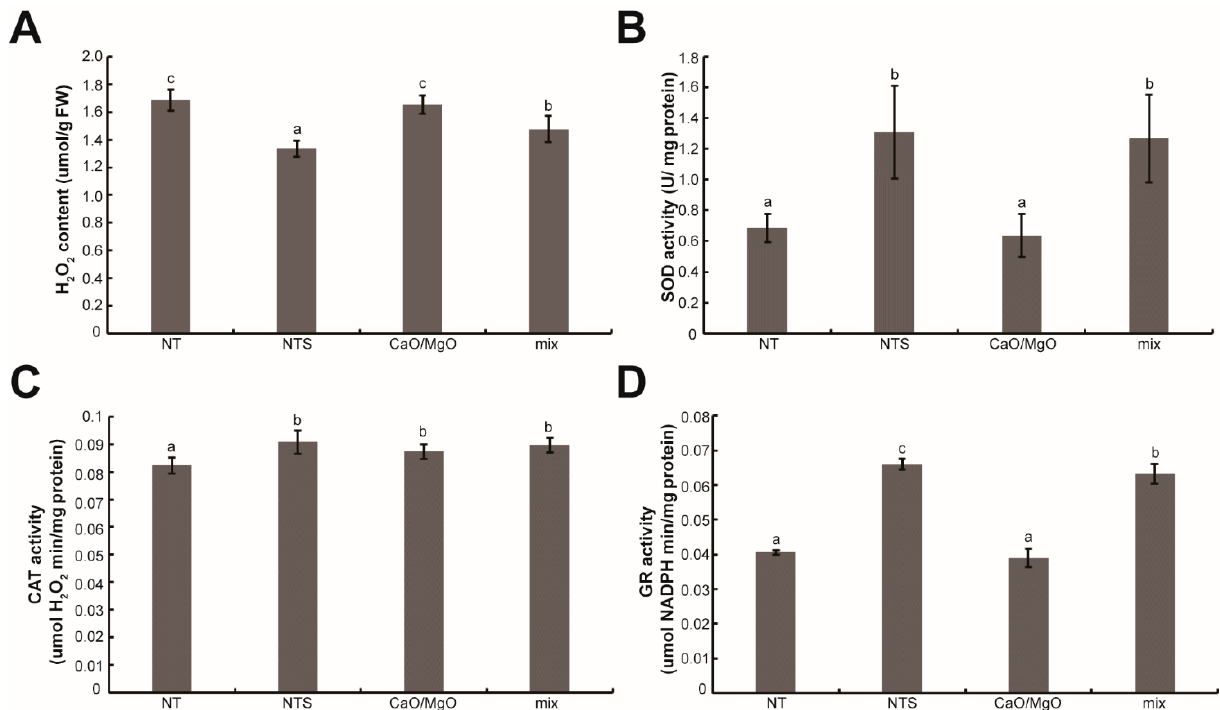
Figure 5. Effects of NTS, CaO/MgO, and mixed treatment on hydrogen peroxide content ( A ) change and SOD ( B ), CAT ( C ), and GR ( D ) activity in leaf lettuce leaves at one week after the fourth treatment. NT, nontreatment group; NTS, NTS treatment group; CaO/MgO, CaO/MgO treatment group; mix, mixed (NTS, CaO, and MgO) treatment group. All experiments were repeated three times, and the error bars indicate standard deviation ( A , n = 12; B – D , n = 9). Different letters above bars indicate statistically significant differences as determined by one-way ANOVA ( p < 0.05).